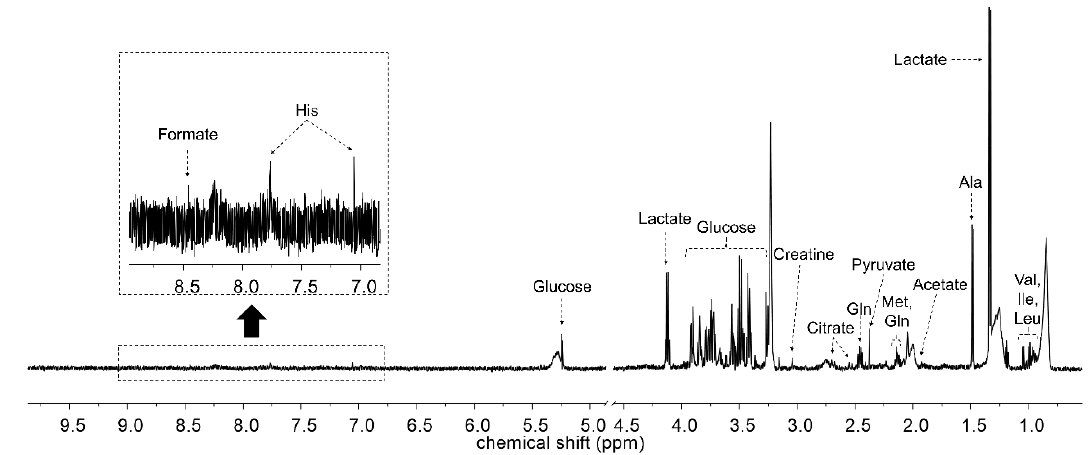
Figure 2. Representative 600 MHz high-resolution magic angle spinning (HR-MAS) nuclear magnetic resonance (NMR) spectrum of dog serum. Residual water area was excluded. Table 1. Identified and quantified metabolites in 600 MHz HR-MAS NMR spectra from dog serum. Relative concentrations were calculated against the total area.